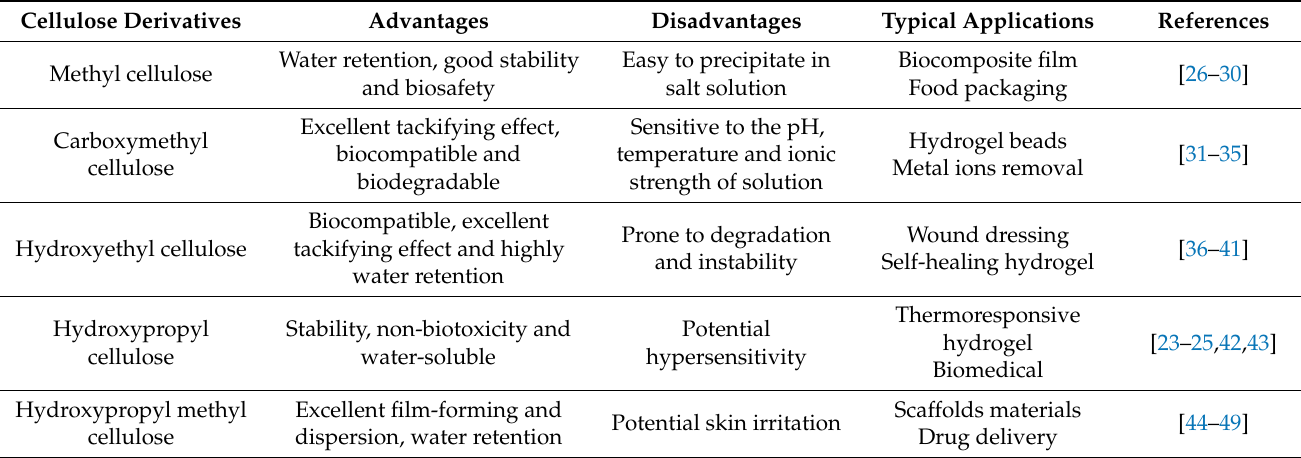
Table 1. Advantages and disadvantages of different cellulose derivatives for the preparation of cellulose-based